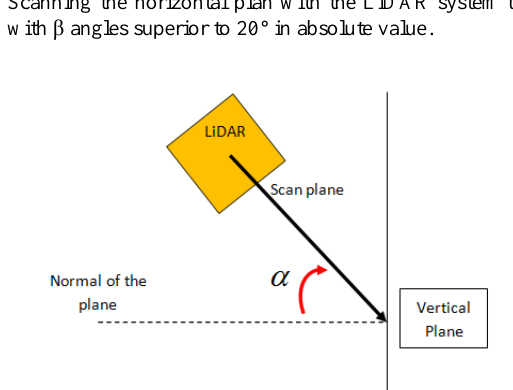
Figure 7: Vertical plan scanned with an α angle (view from above)